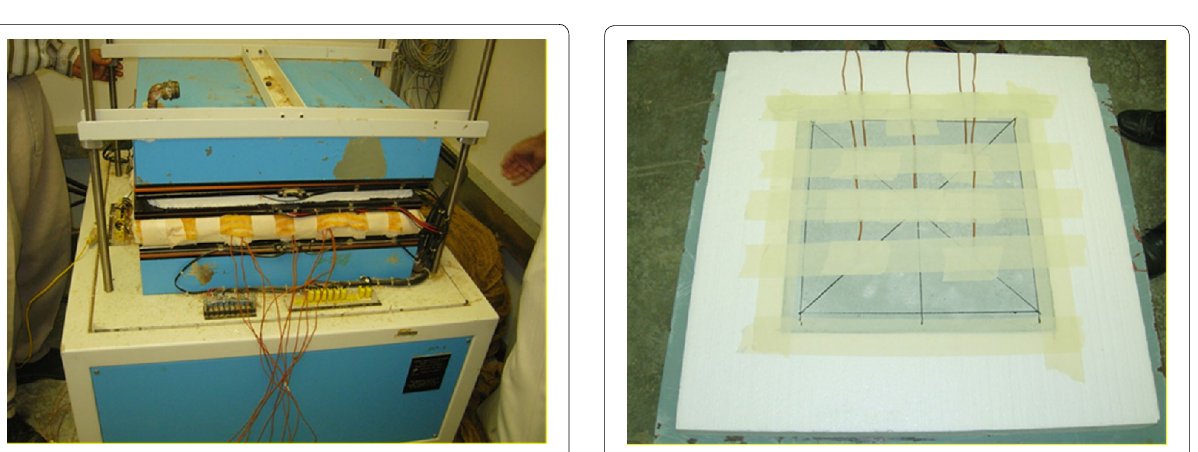
Fig. 4 Specimens with thermocouple wires fixed on the concrete slab surfaces for measuring